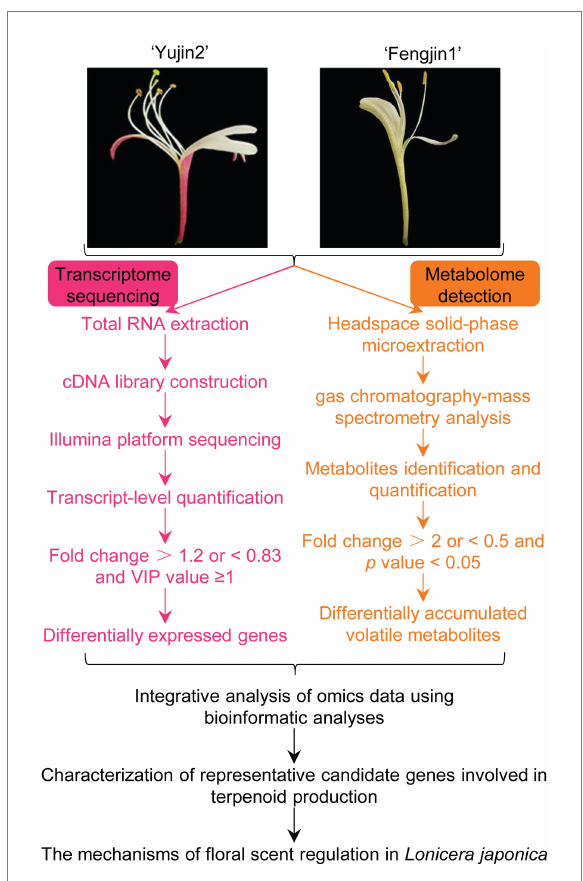
FIGURE 1 Overview of the metabolomics and transcriptomics workflow. Lonicera japonica flowers (LJFs) at the silver flowering stage of two contrasting varieties of L. japonica, ‘Yujin 2’ and ‘Fengjin 1’ were collected. Headspace solid-phase microextraction (HS- SPME) coupled with gas chromatography–mass spectrometry (GC–MS) and transcriptomics analysis were performed for volatile organic compound (VOC) profiling and global gene expression patterns, respectively. Integrated metabolomics and transcriptomics analysis serves to elucidate the regulatory mechanism of floral scents of LJFs by bioinformatic